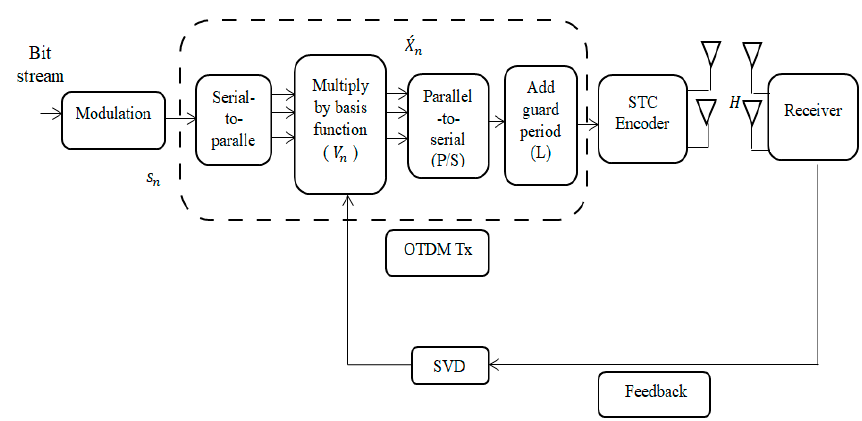
Figure 1. Figure 1. Space-time coded orthogonal transform division multiplexing (STC OTDM) transmitter technique.